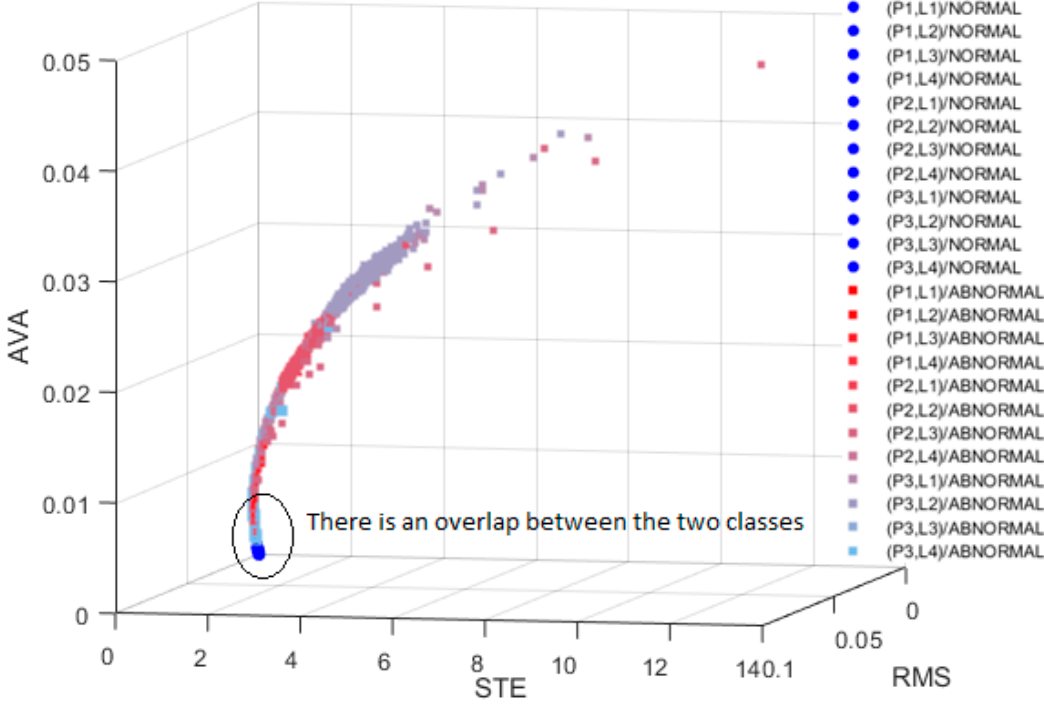
Figure 13. State scattering based on features extracted from the AE signal of channel 2 (CH2).